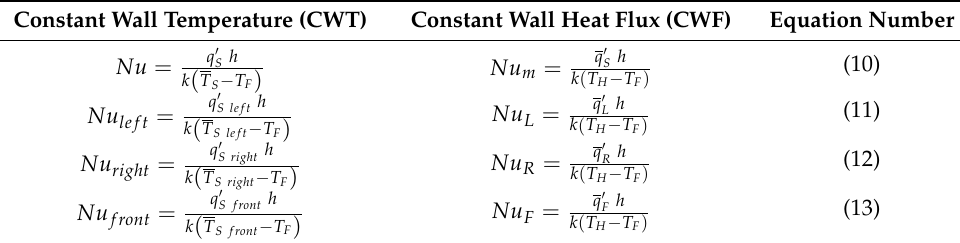
T S , T S left , T S right , T S front are the average temperatures for the entire, left, right and front heated surfaces of the slender cuboid, respectively and q (cid:48) S , q (cid:48) L , q (cid:48) R , q (cid:48) F are the mean heat fluxes from the entire, left, right, and front heated surfaces of the slender cuboid